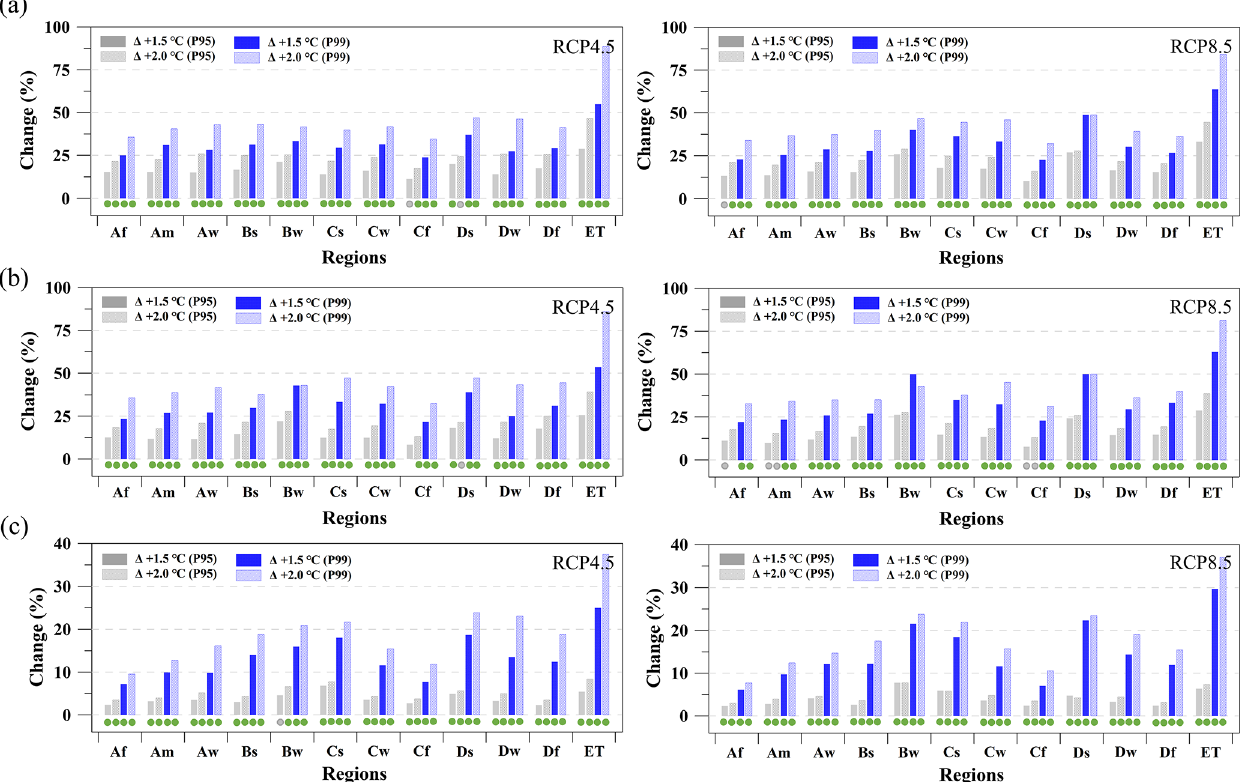
Figure 7. Relative changes in the (a) total amount, (b) frequency, and (c) intensity of the extreme precipitation indices (P95: very wet day precipitation, P99: extreme wet day precipitation) for the 12 climate zones derived from the MME of the five GCMs under 1.5 and 2.0 ◦ C of global warming compared to the reference period (REF). Green circles (gray circles) denote 100% (over 80%) intermodel